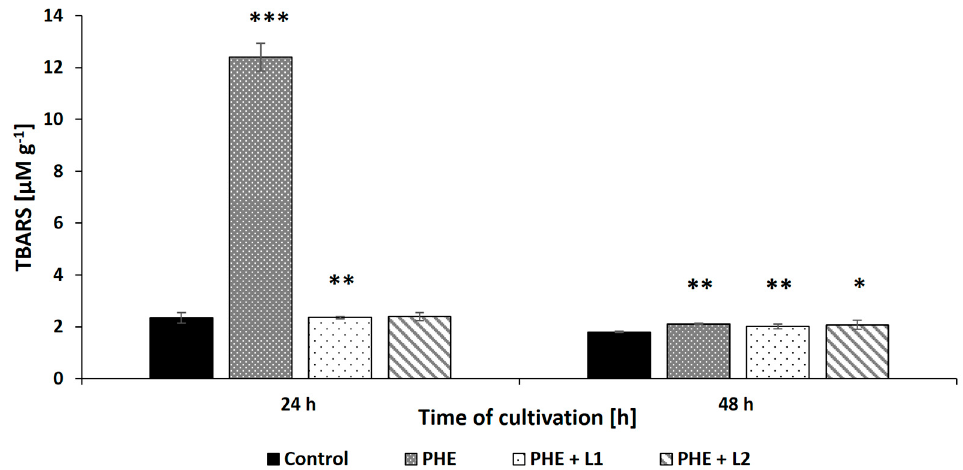
Figure 6. The TBARS content in the biomass of N. pironii exposed to PHE, L1, or PHE + L1. Data represent mean ± SE. * p ≤ 0.05, ** p ≤ 0.01, *** p ≤ 0.001.